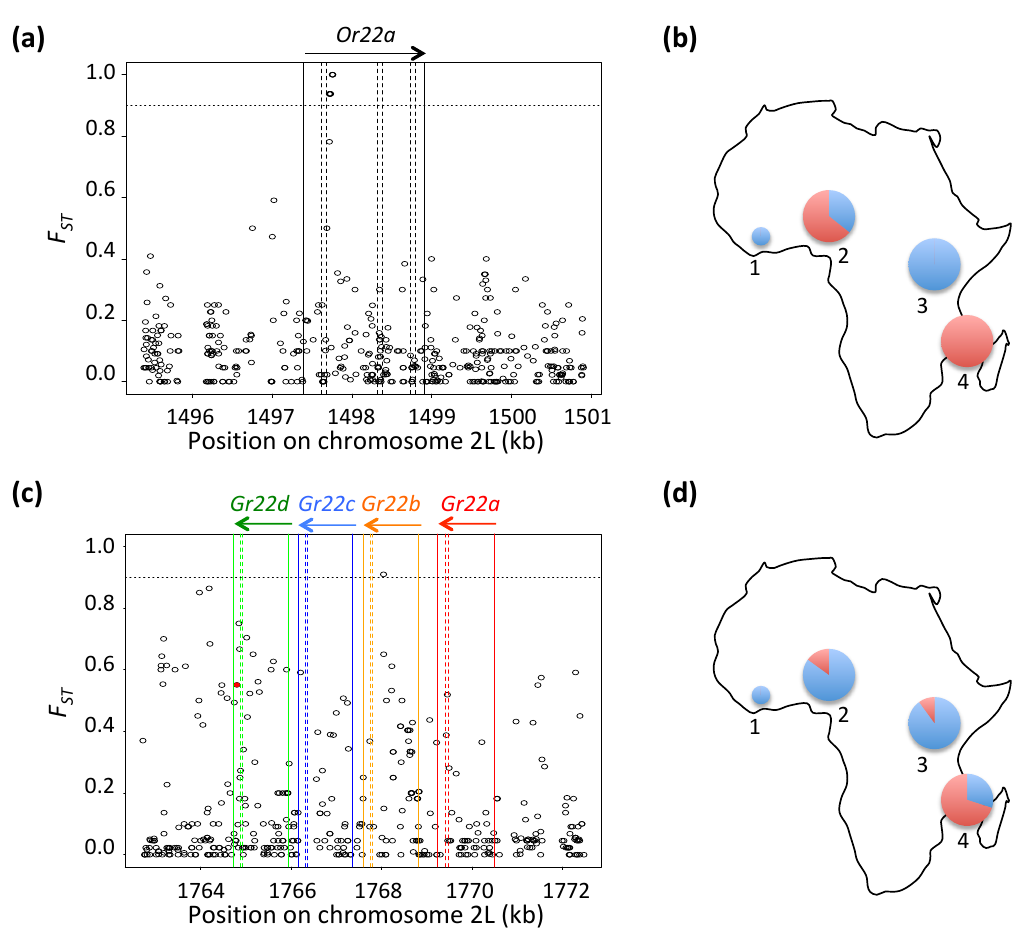
Figure 2. Genetic differentiation ( F ST ) profile between D. y. mayottensis and D. y. yakuba (Kenya) at ( a ) the olfactory receptor Or22a gene, with ( b ) the geographical distribution of its most differentiating site in Mayotte, Kenya, Cameroon and the reference genome strain from C ô te d’Ivoire, and at ( c ) the gustatory receptor genes of the Gr22a clade showing the non-sense mutation at Gr22d (red dot) and ( d ) its geographical distribution. Solid and dashed vertical lines indicate gene and exon boundaries, and arrows indicate the gene sense. Dotted horizontal line indicates the F ST value corresponding to the 0.95 quantile of the msms